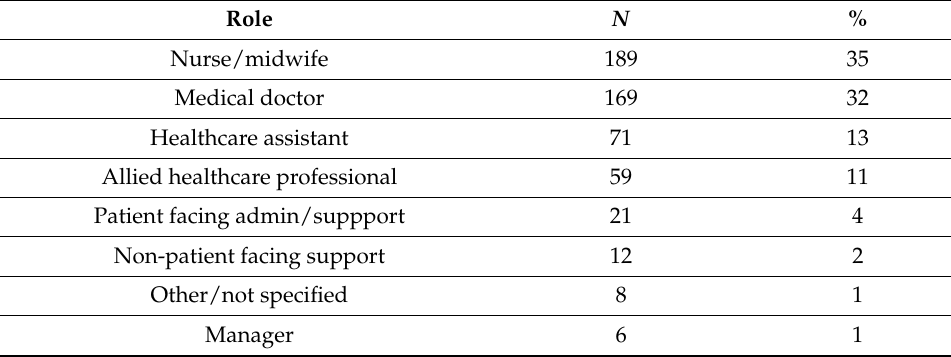
Table 1. Roles of healthcare staff